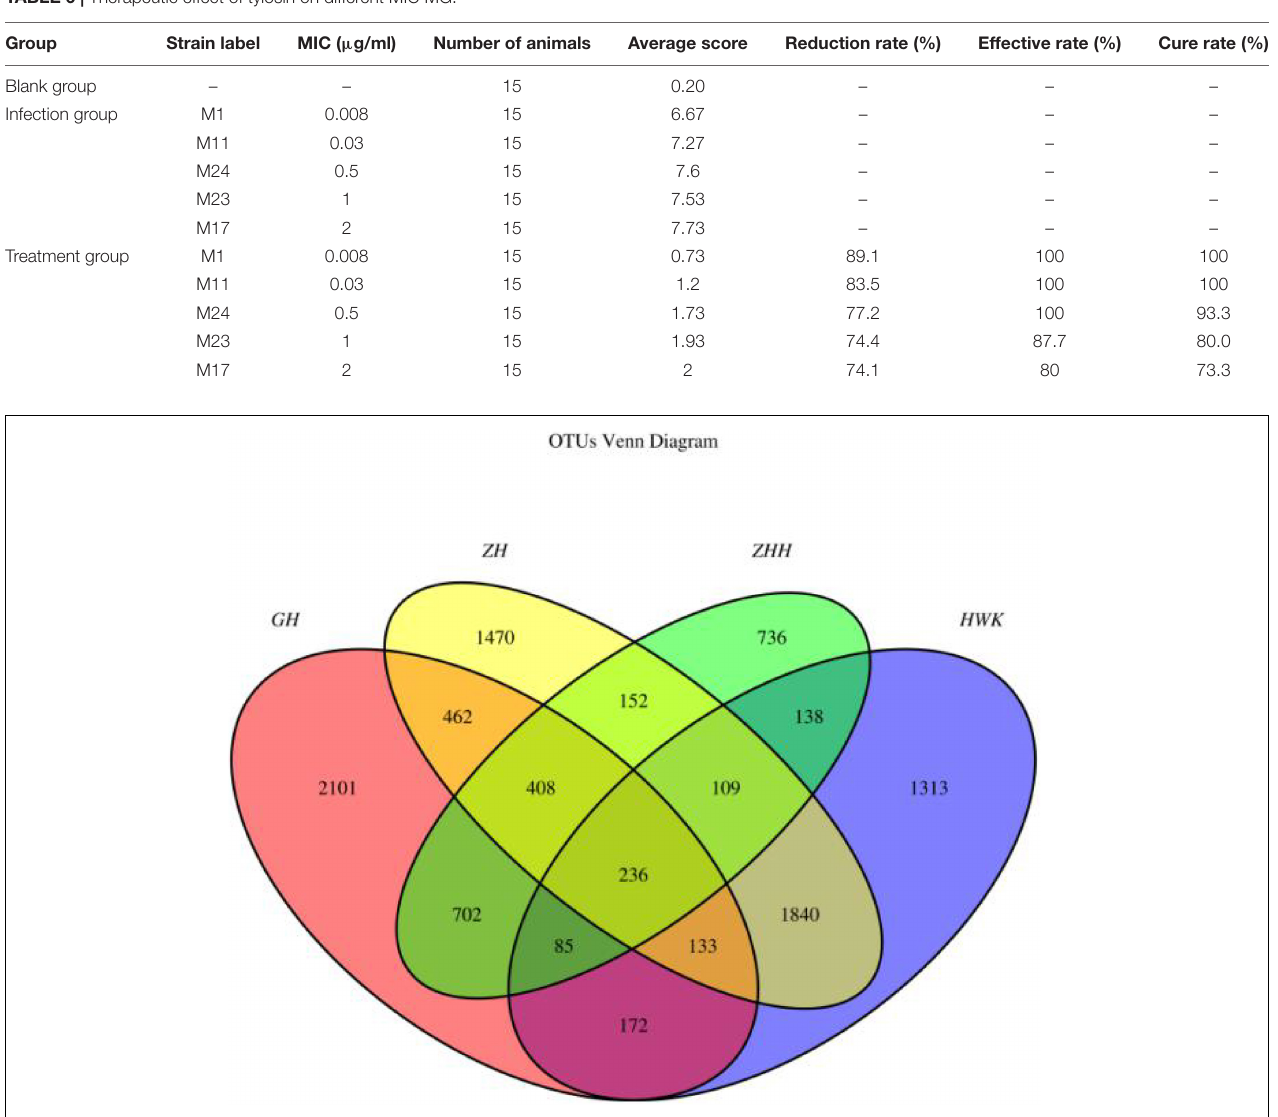
TABLE 6 | Therapeutic effect of tylosin on different MIC MG.